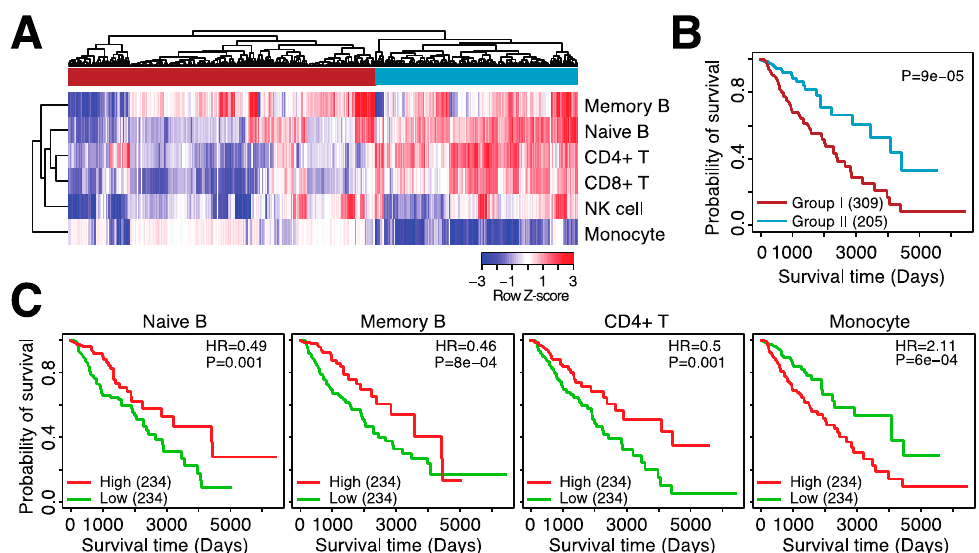
Figure 2. Patterns of immune infiltration in low-grade glioma. ( A ). Heatmap depicting the infiltration scores for six immune cell types in TCGA-LGG. Top sidebar indicates the grouping of the samples based on hierarchical clustering. ( B ). Kaplan–Meier plot depicting differential overall survival between group I and group II. ( C ). Kaplan–Meier plots comparing low and high infiltration of four immune cell types. HR = hazard ratio. p = log-rank p-value.